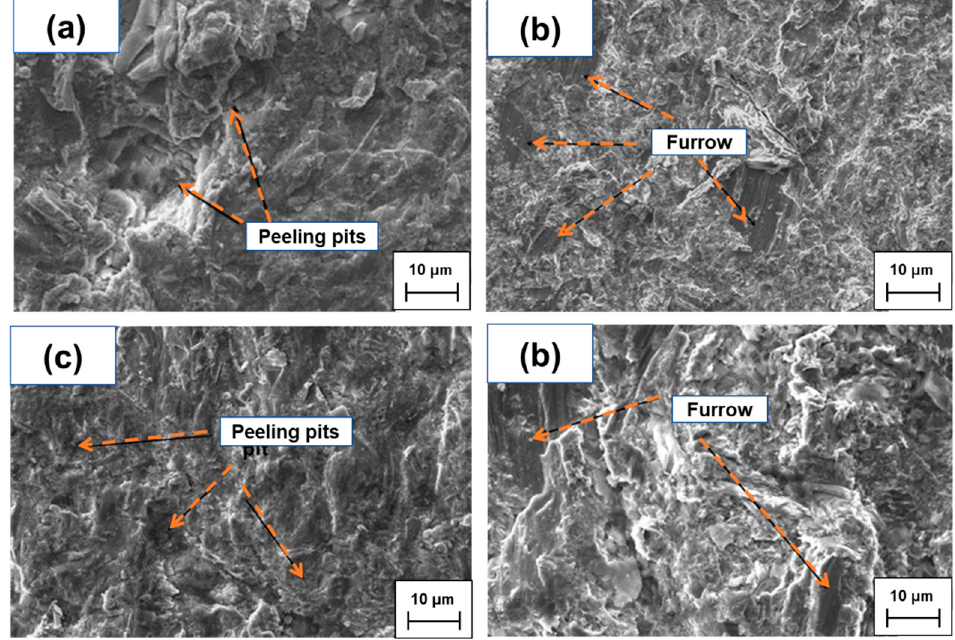
Figure 5. Wear surface with white cast iron ( a ) 0 wt. % Ti 3 AlC 2 ( b ) 1.0 wt. % Ti 3 AlC 2 additive. ( c ) 2.0 wt.% Ti 3 AlC 2 additive ( d ) 3.0 wt.% Ti 3 AlC 2 additive.